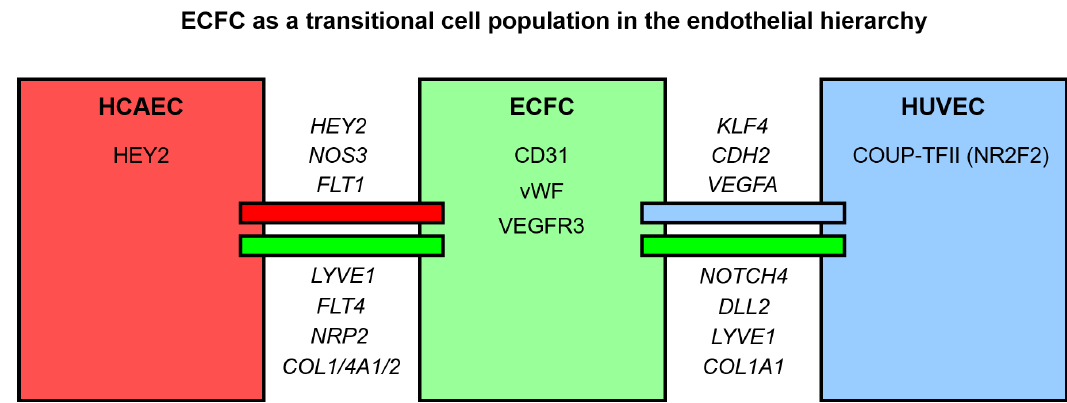
Figure 10. Graphical summary of the results. We suggest ECFC as a transitional cell population in the endothelial hierarchy overexpressing extracellular matrix/basement membrane components, lymphatic endothelial markers, and also venous endothelial markers as compared with mature arterial ECs and arterial endothelial markers in comparison with mature venous ECs. Changes at the protein level are within the boxes whereas changes at the transcriptomic level are above or below the lines (italicized gene names). Genes above the red and blue lines are upregulated in HCAEC and HUVEC, respectively, as compared with ECFC. Genes below the green lines are upregulated in ECFC in comparison with HCAEC (left green line) and HUVEC (right green line), respectively.